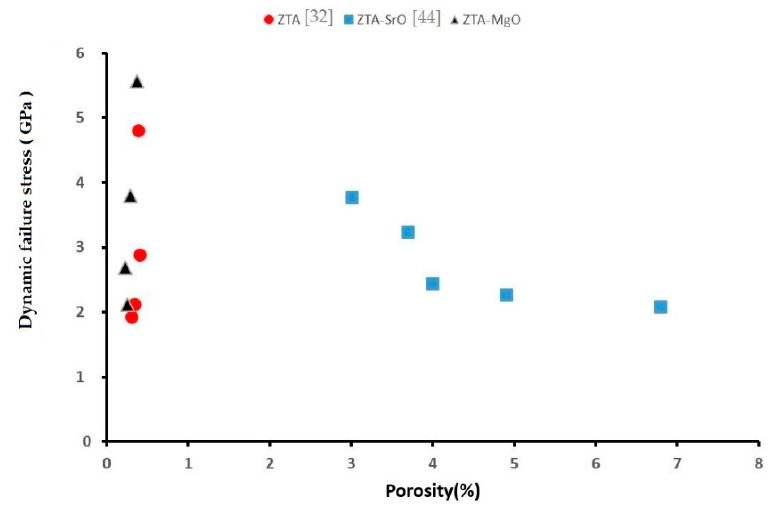
Figure 10. Relation between the porosity and dynamic failure.